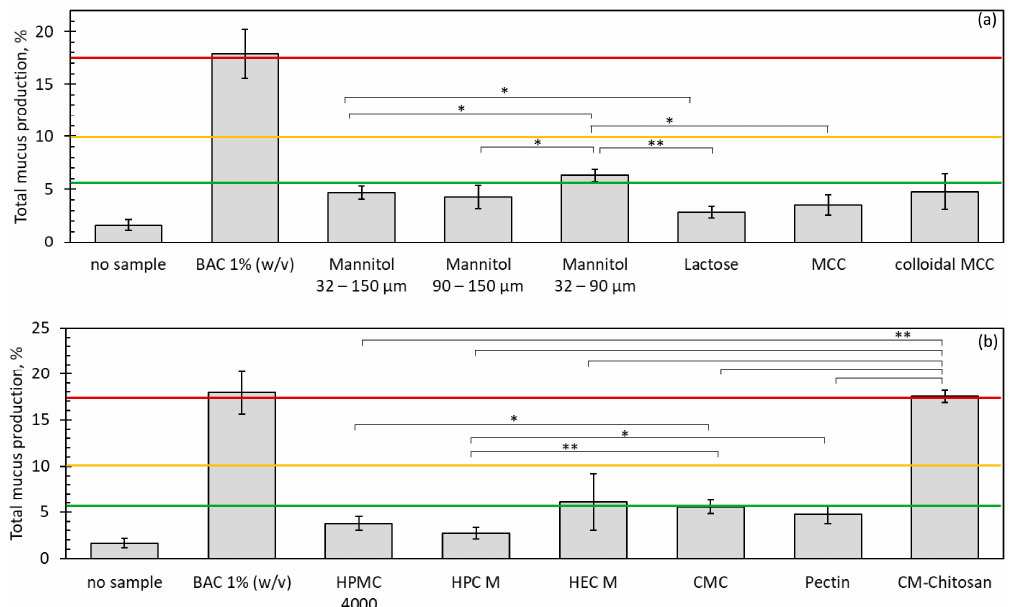
Figure 5. Total mucus production from three contact periods in the slug mucosal irritation assay, expressed as a percentage of the initial bodyweight of the slugs. ( a ) Fillers; ( b ) mucoadhesive polymers. Unless otherwise stated, sieve fractions from 32–150 µ m were used. The lines display the limit values for the different categories of nasal discomfort, as defined in [21]: below the green line, no discomfort; below the yellow line, mild discomfort; below the red line, moderate discomfort; above the red line, severe discomfort. n = 3, error bars = sd, * = p < 0.05, ** = p < 0.01.